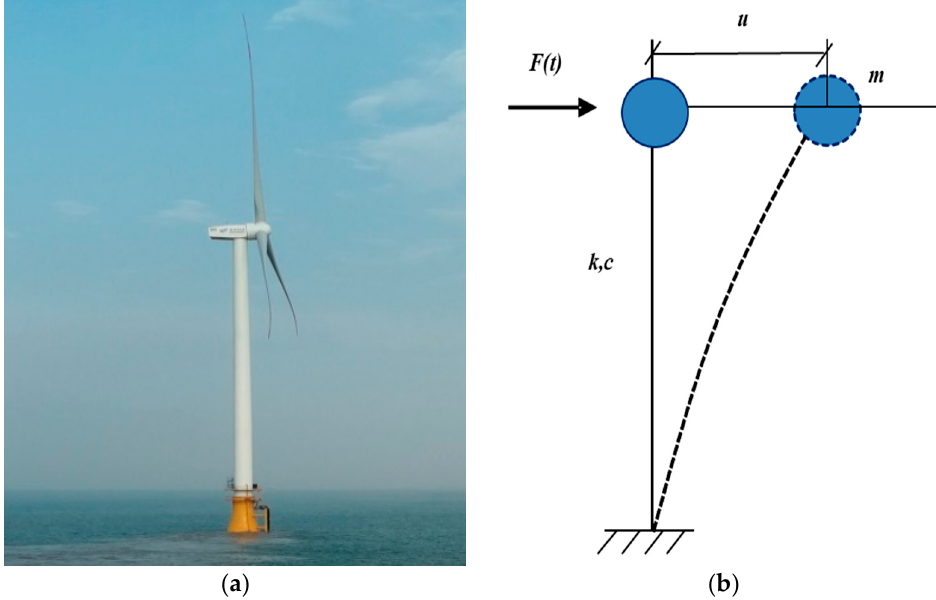
Figure 1. Prototype and equivalent dynamic model of the offshore wind turbine (OWT). ( a ) The OWT supported by bucket foundation; ( b ) the equivalent dynamic model of the OWT.